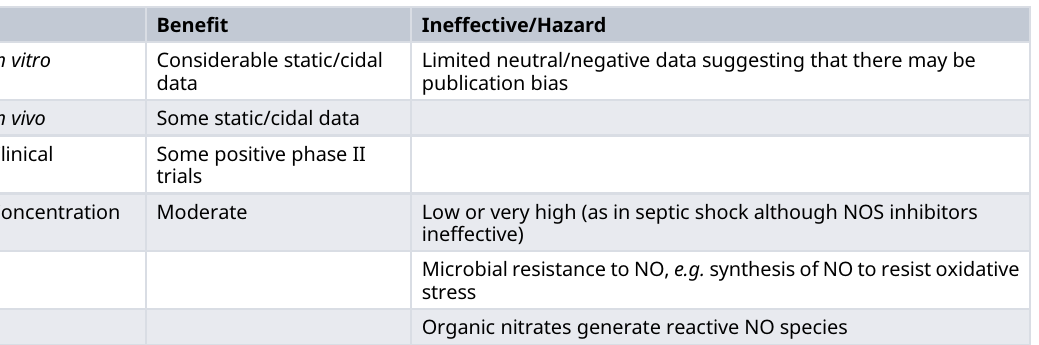
Table 11. Balance between potential beneficial and hazardous effects of NO sources in preventing and treating